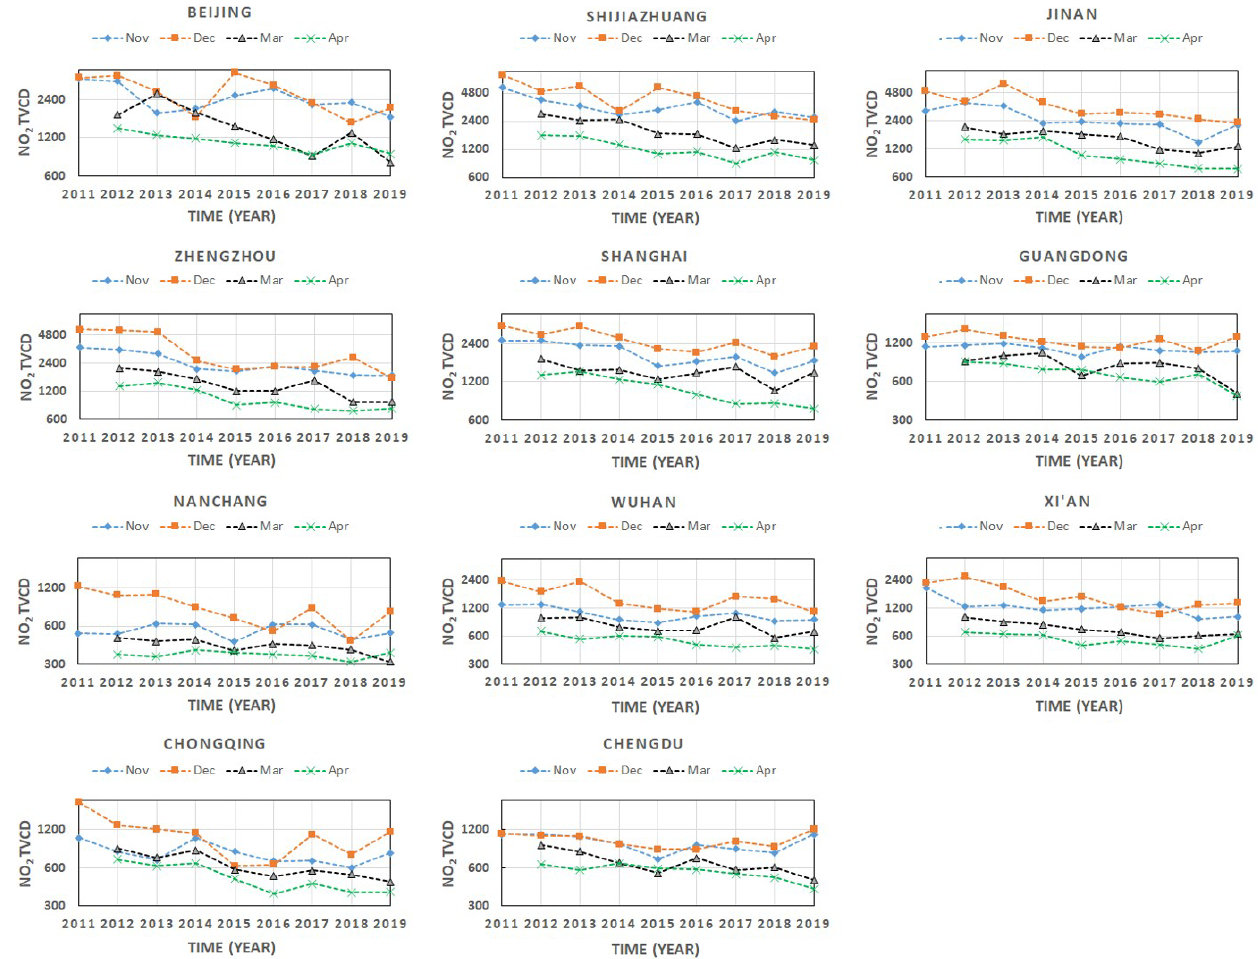
Figure A2. Time series of monthly-averaged NO 2 TVCDs over each of the 11 regions, for each of the months November, December, March and April from 2011 to 2019. The data points for each month are connected with dotted lines for easy